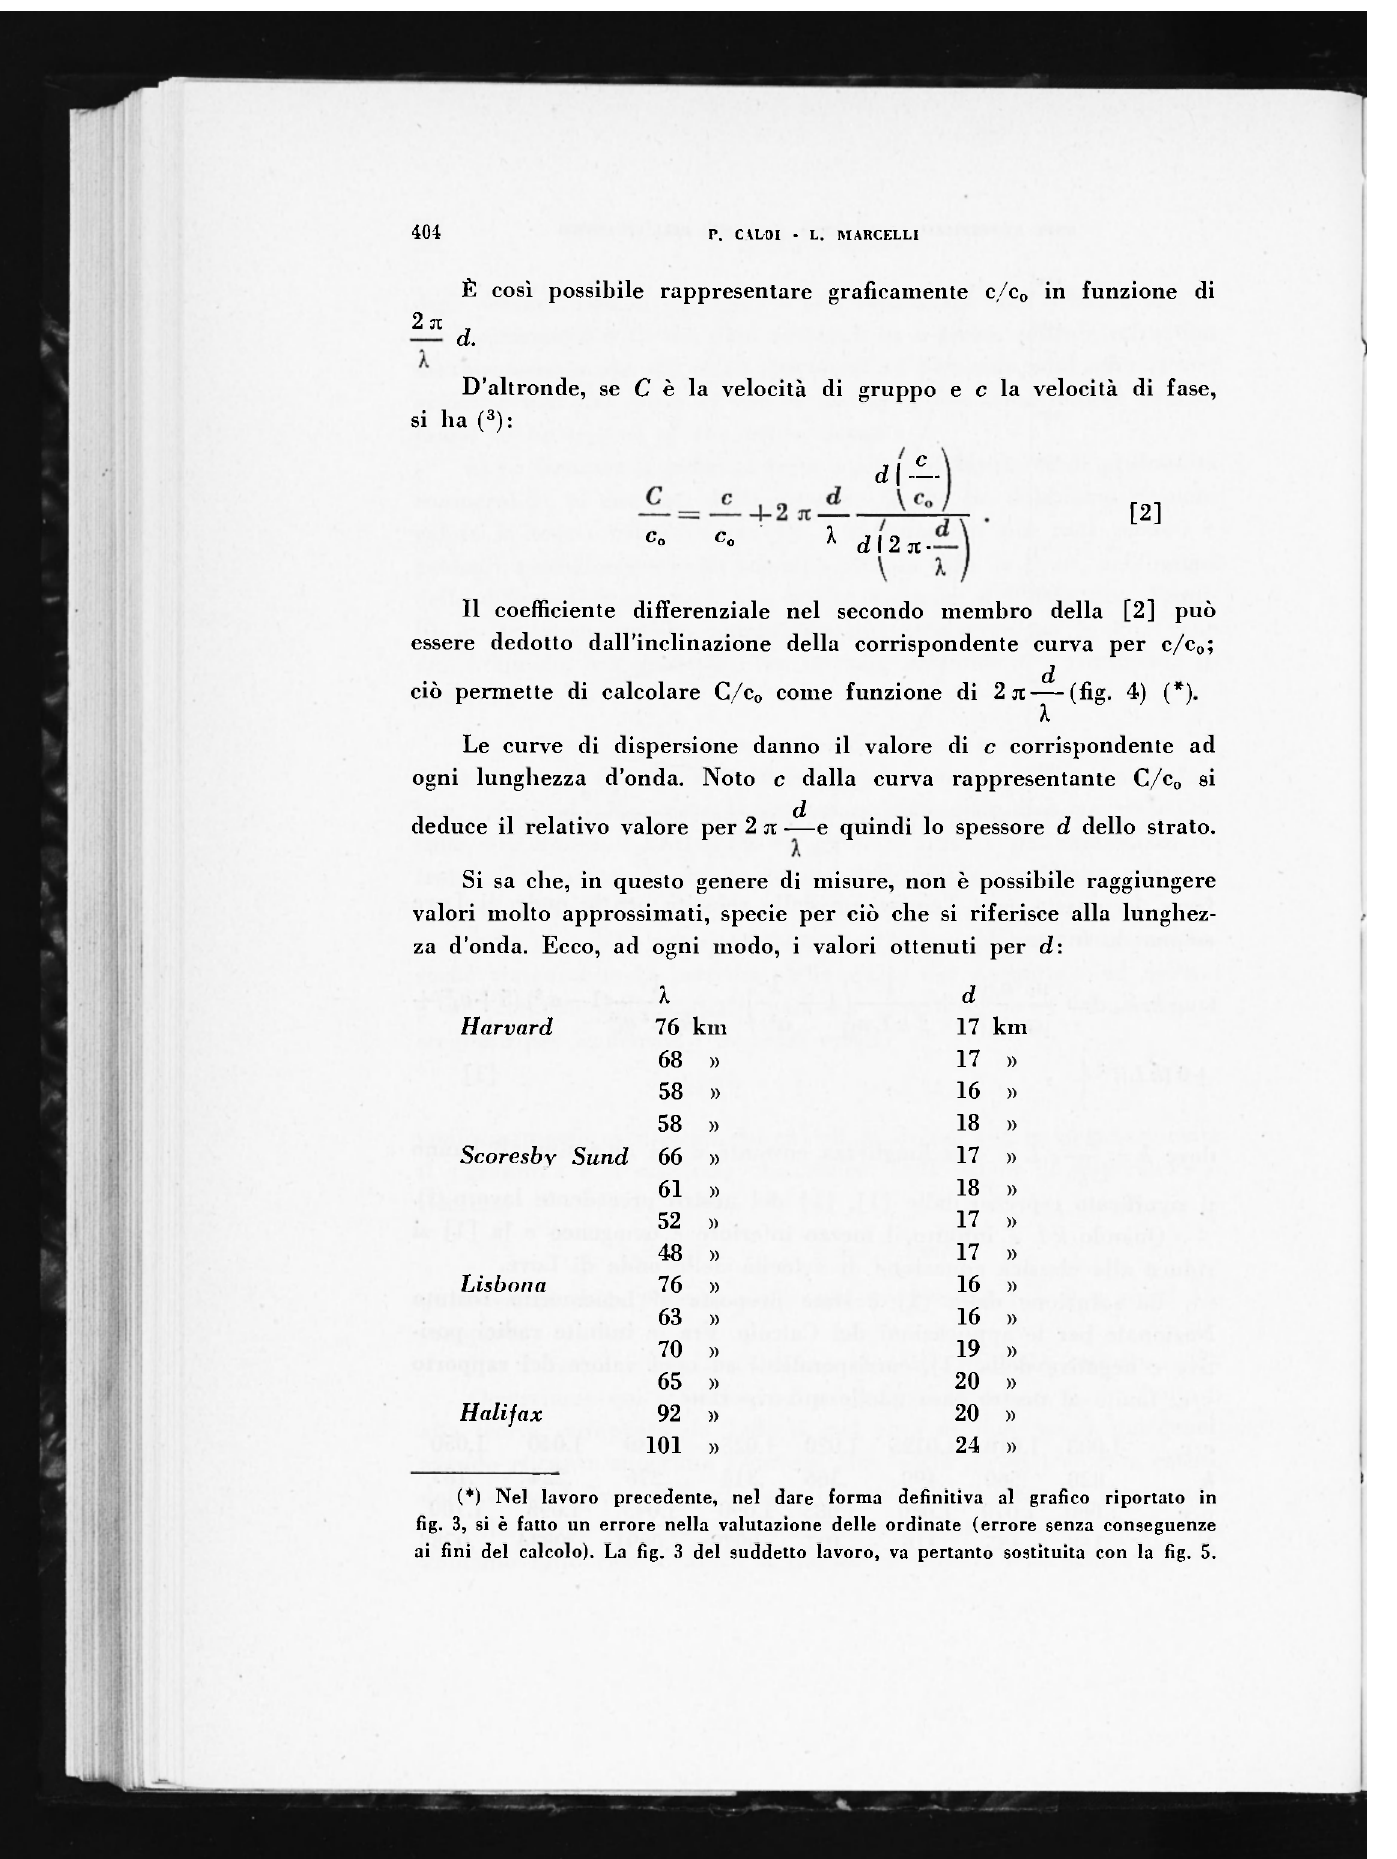
fig. 3, si è fatto un errore nella valutazione delle ordinate (errore senza